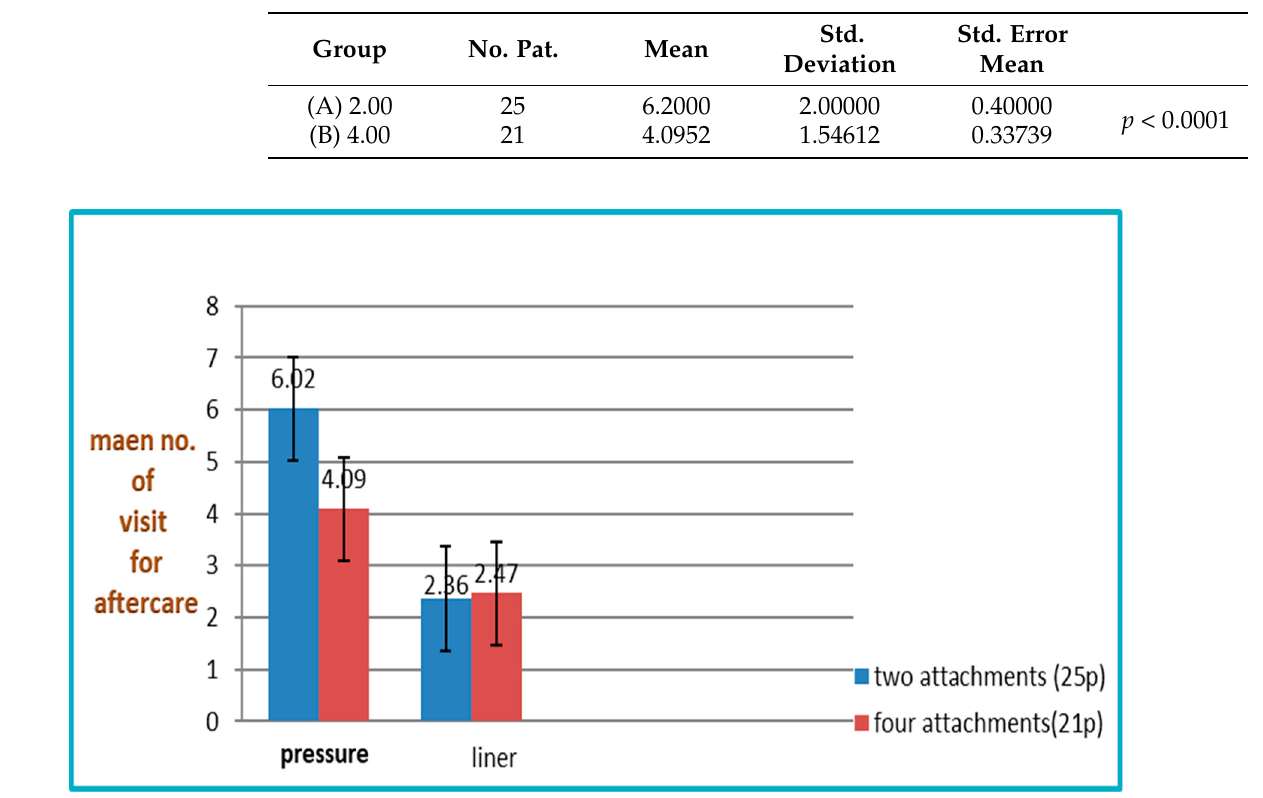
Table 3. Chi-square tests (No/Yes) attachment replacement. Table 1. t -test pressure sores points.